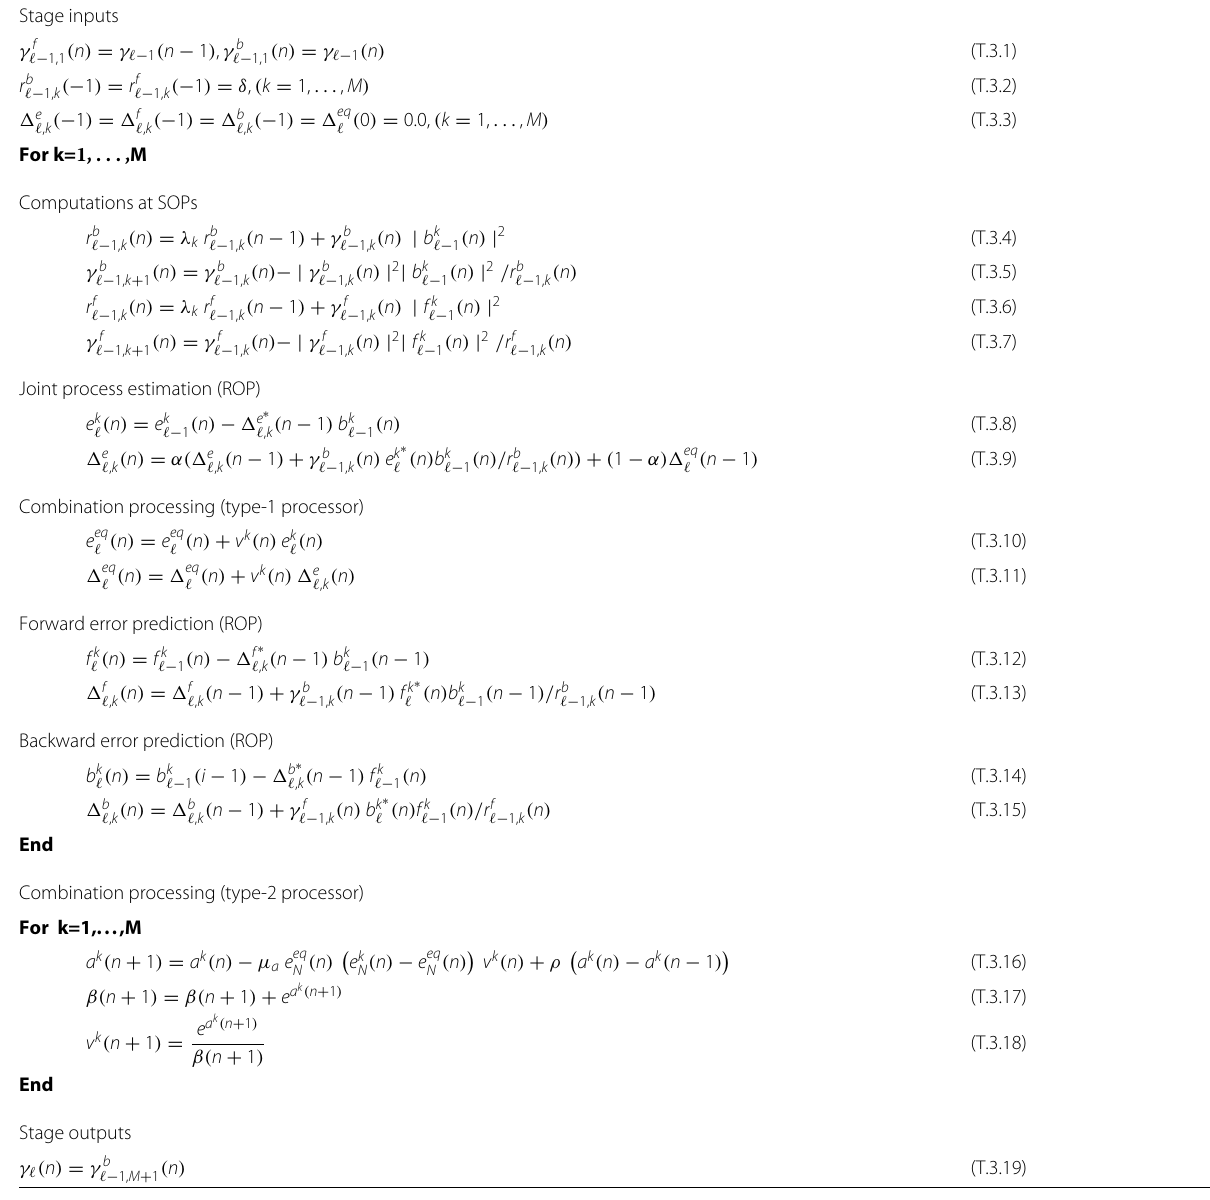
Table 3 The R-CMLF